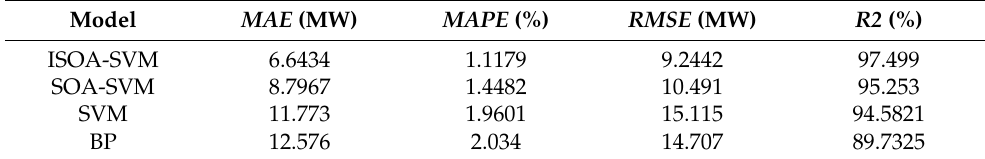
Table 6. Evaluation table of the power load forecasting results of Case 2.